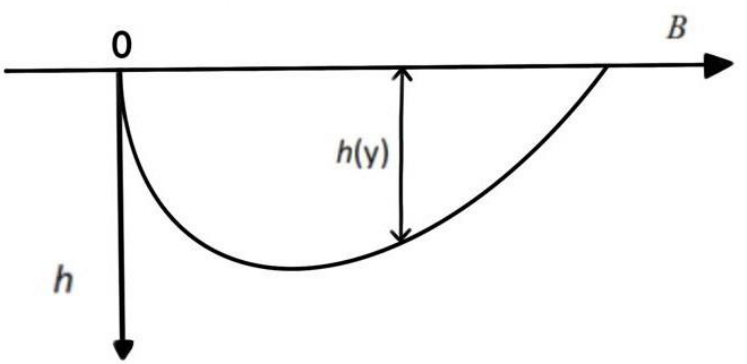
Figure 2. Sketch of cross-section morphology.